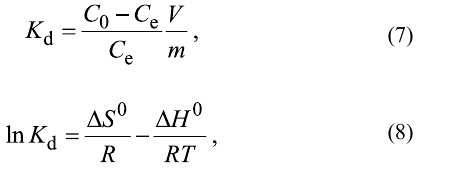
Table 2: Adsorption isotherm parameters of heavy metals onto SiNL.